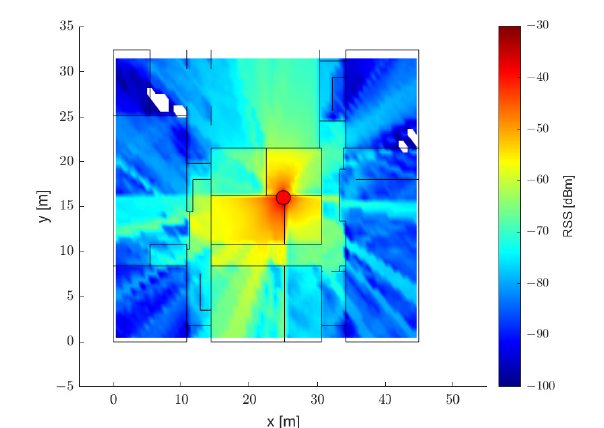
Figure 6. RSS map for an AP in the 2.4 GHz band.